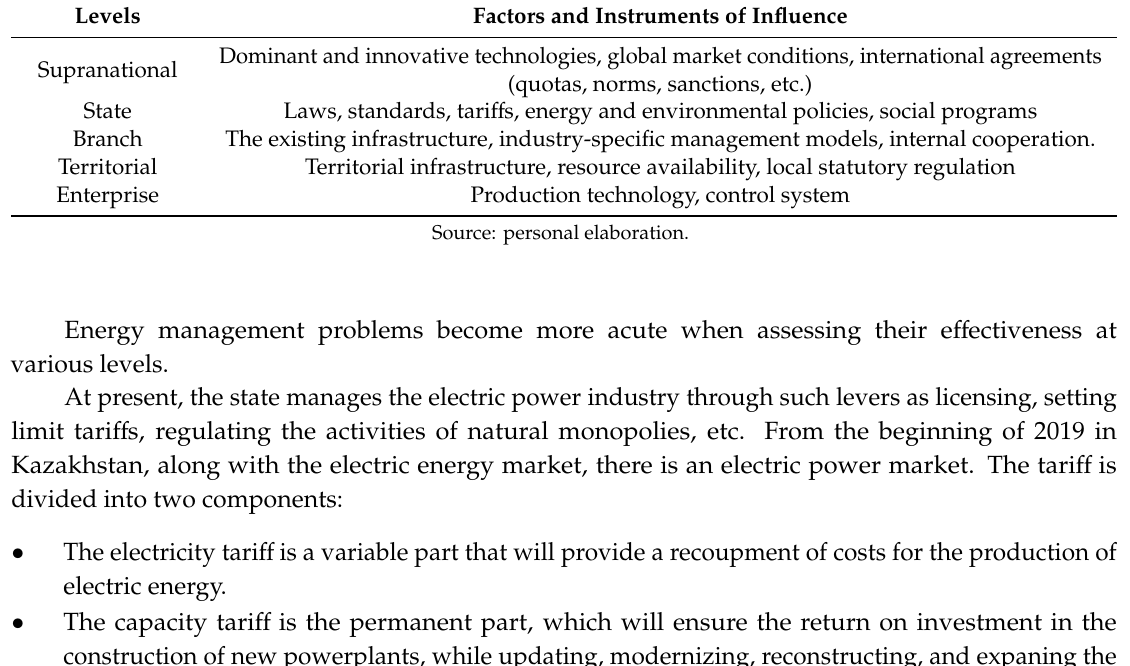
Table 3. The share of electricity costs in the total cost structure (%).